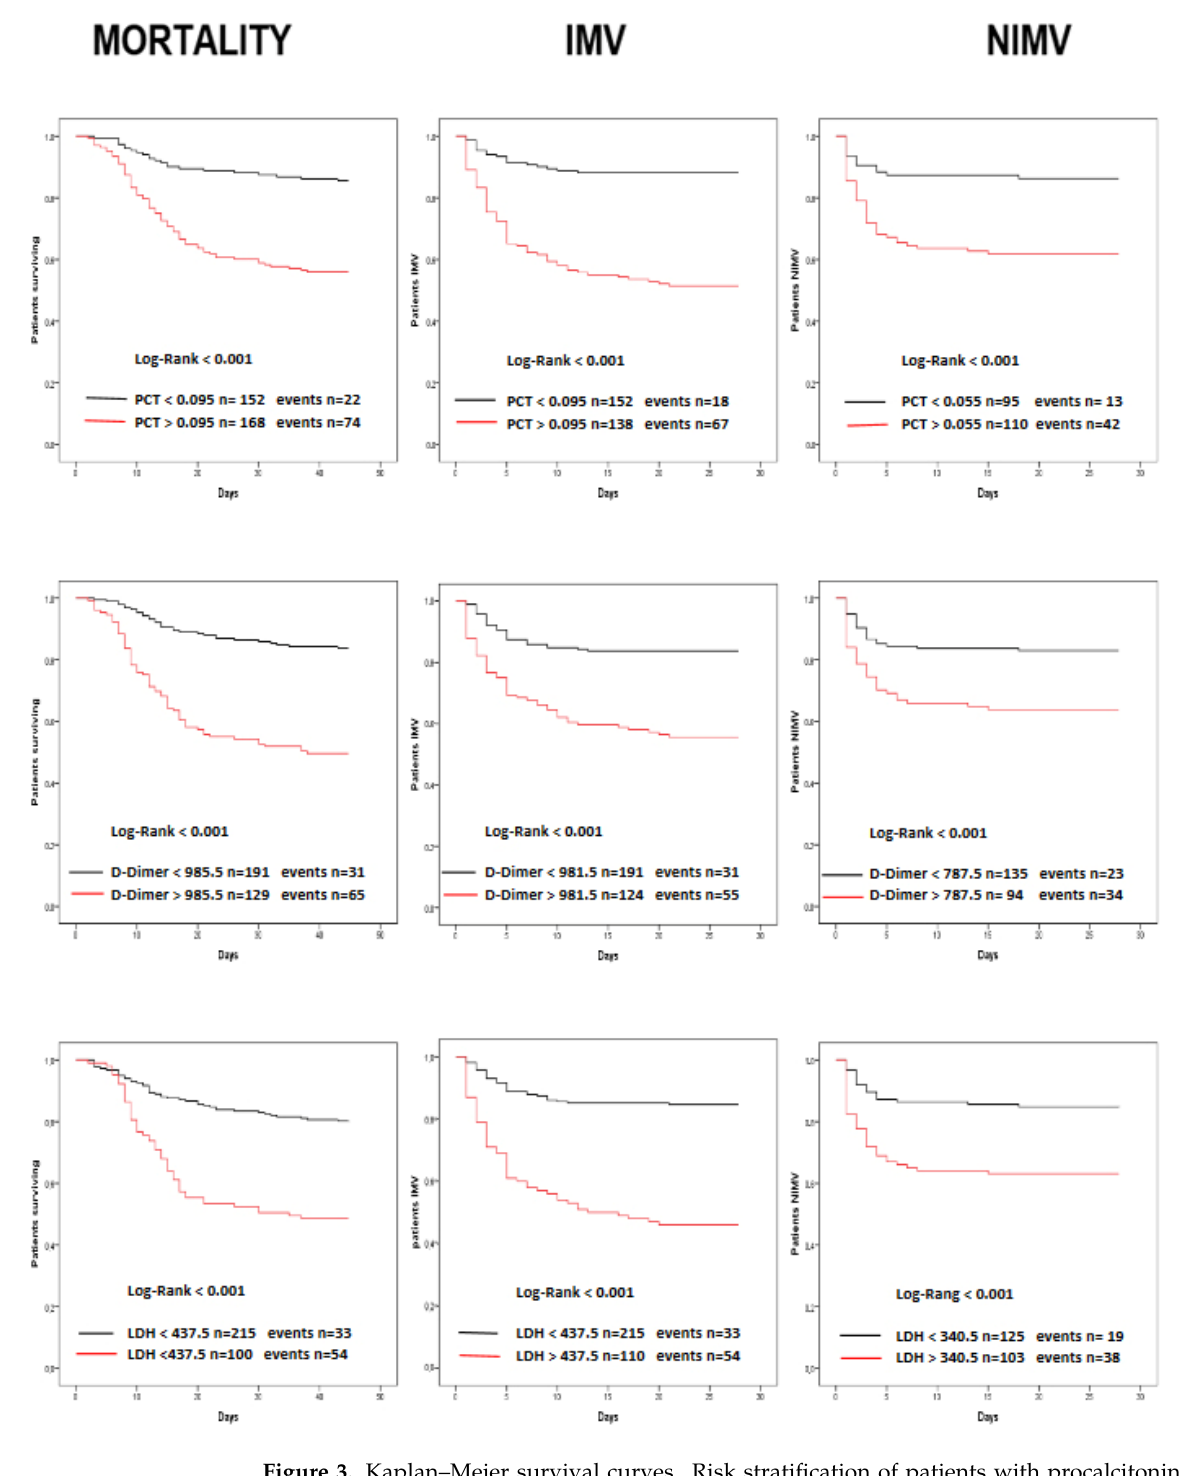
Figure 3. Kaplan–Meier survival curves. Risk stratification of patients with procalcitonin (PCT) levels greater or less than 0.095 ng/mL, D-dimer levels greater or less than 985.5 ng/mL and lactate dehydrogenase (LDH) greater or less than 439.5 U/L at admission in the Emergency Department. IMV, invasive mechanical ventilation; NIMV, non-invasive mechanical ventilation.